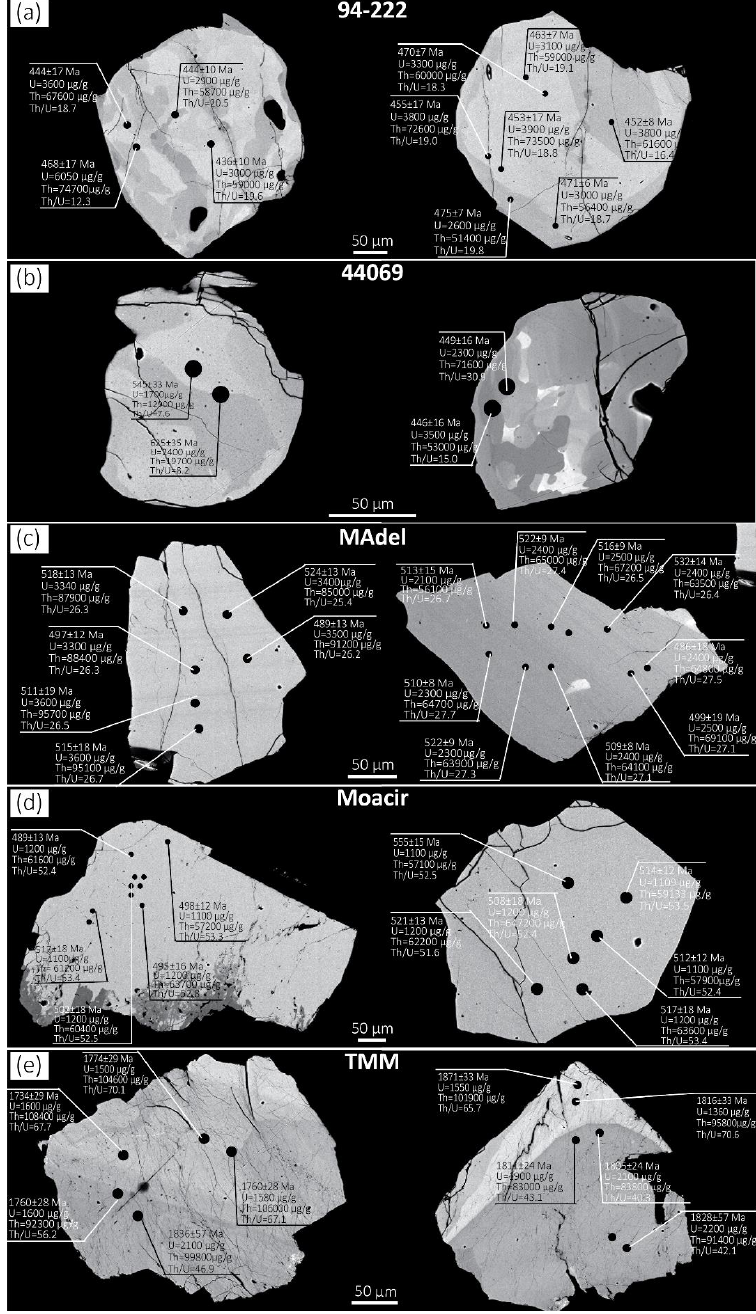
Figure 1. BSE images of the characteristic grains of monazite reference material ( a ) 94-222, ( b ) USGS 44069, ( c ) MAdel, ( d ) Moacir and ( e ) TMM showing different zoning patterns. The spots on the monazite grains represent the laser spots (spot size = 10 µm, repetition rate = 10 Hz) during four analytical sessions 120605, 130111, 130115 and 130320. It needs to be noted that solely the most distinctive monazite grains are shown here and not all grains analyzed, as well as laser spots.